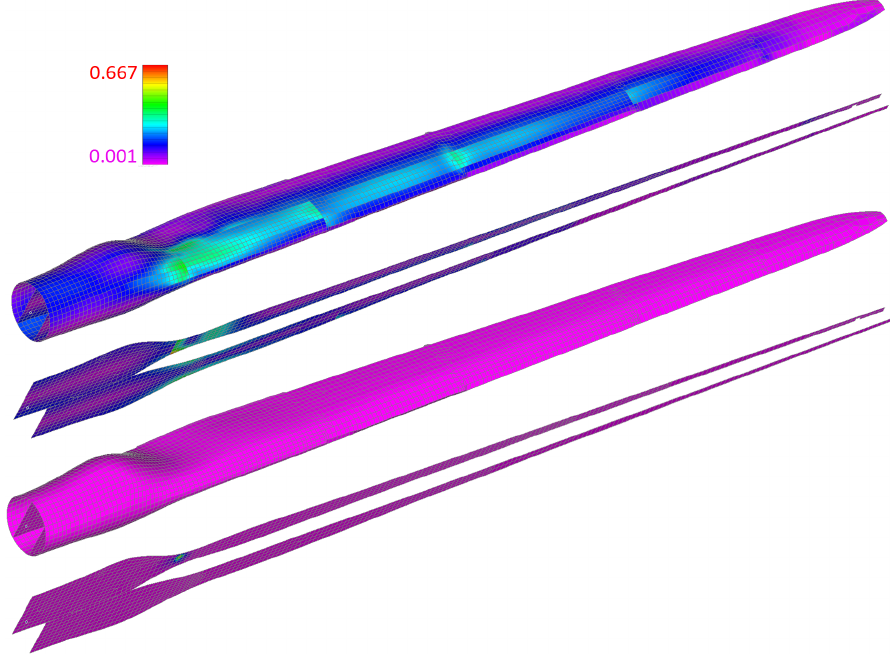
Figure 15. FEA fiber failure index and buckling eigenvector results for MOSOP2 solution